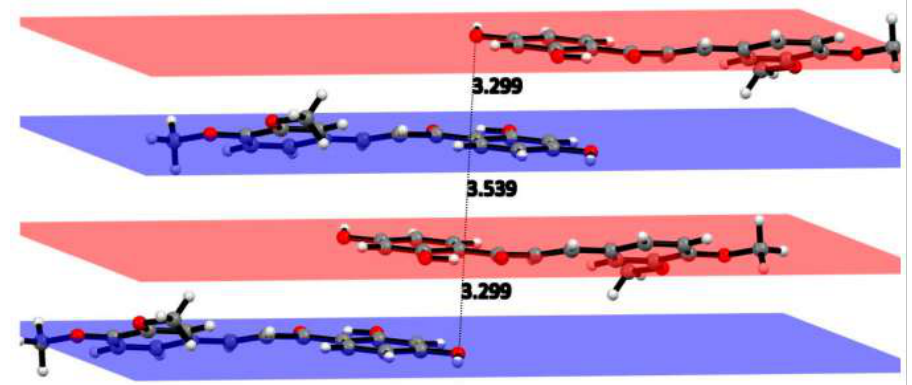
Figure 3. Shifted ring stacking interactions between molecules of DHDM. The intermolecular distances alternate between 3.299 and 3.539 Å.